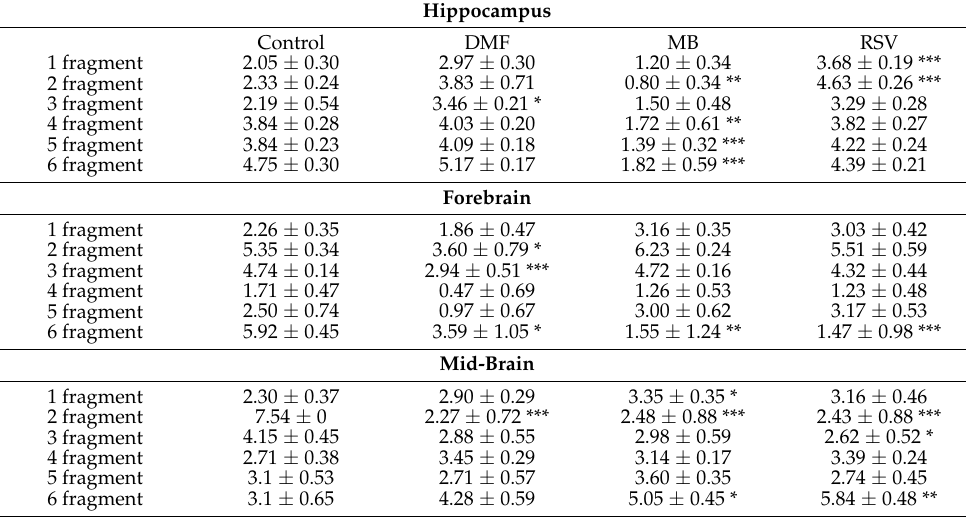
Figure 7. Amount of mtDNA damage in the ( A ) hippocampus, ( B ) cortex, ( C ) mid-brain. The results expressed as means ± SEM. Control n = 8, DMF = 9, MB = 6, RSV = 7. The results expressed as means ± SEM. Control n = 8, DMF = 9, MB = 6, RSV = 8. * p < 0.05, ** p < 0.01, *** p < 0.001, comparison of the control group and treated groups using Tukey’s post-hoc test. Table 5. Amount of mtDNA damage.